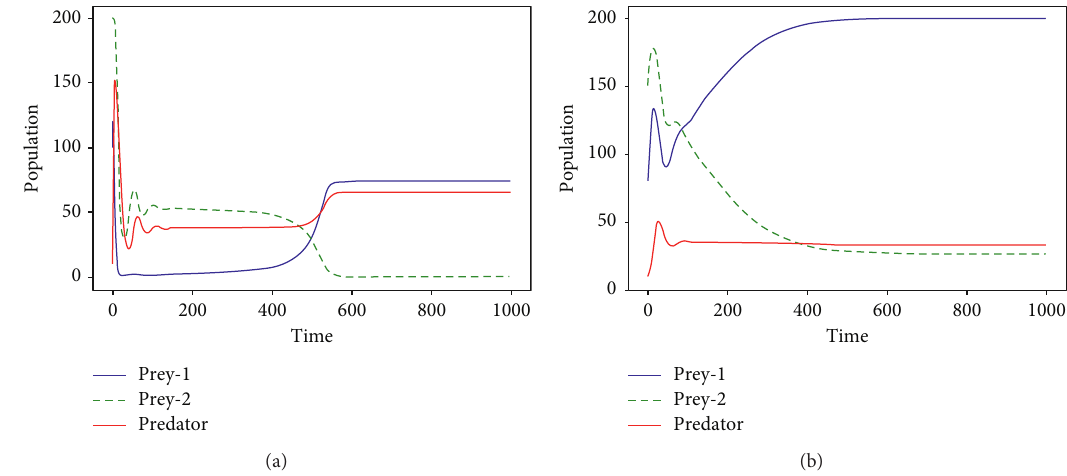
� 0 . 001 ( r � r � 0 . 15, 11 1 2 � r � 0 . 15, r � − 0 . 15; 1 2 3